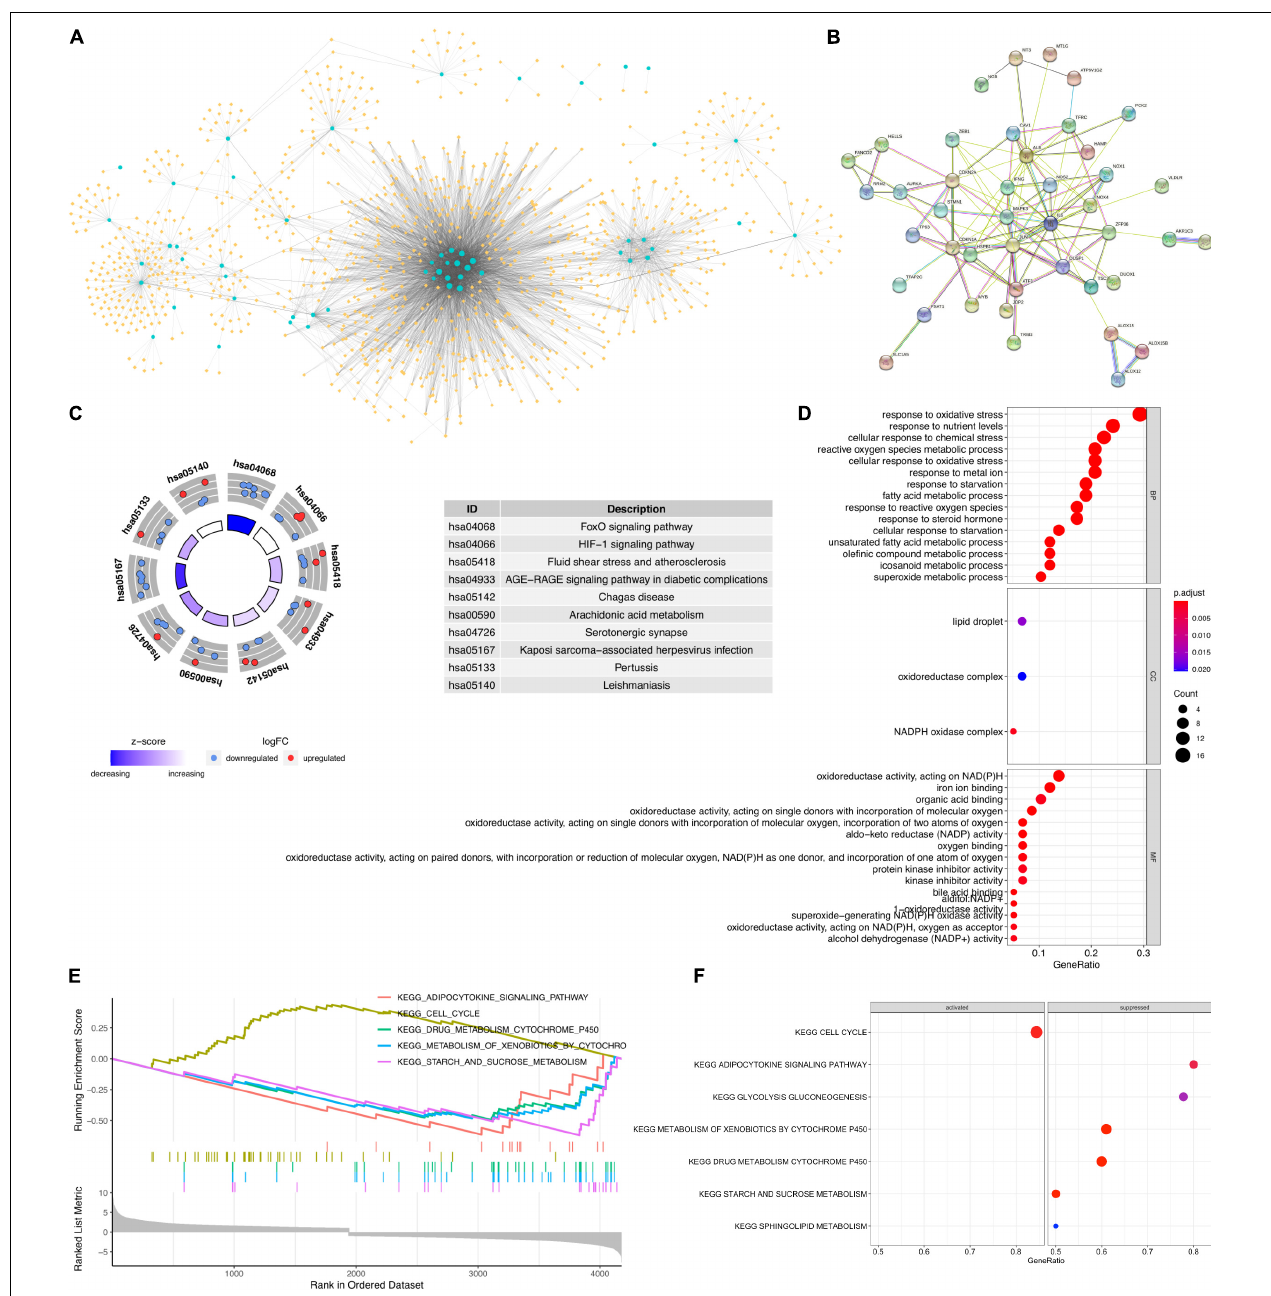
FIGURE 2 | (A) Ferroptosis-related lncRNA–mRNA co-expression network. Blue circles are differentially expressed (DE) ferroptosis-related genes. Yellow diamonds are co-expressed lncRNAs. (B) Protein–protein interaction (PPI) network for the DE ferroptosis-related genes involved in the co-expression network. (C) Kyoto Encyclopedia of Genes and Genomes (KEGG) enrichment analysis for the targets of ferroptosis-related lncRNAs. (D) Gene Ontology (GO) annotation analysis for the targets of ferroptosis-related lncRNAs. (E,F) Gene set enrichment analysis.